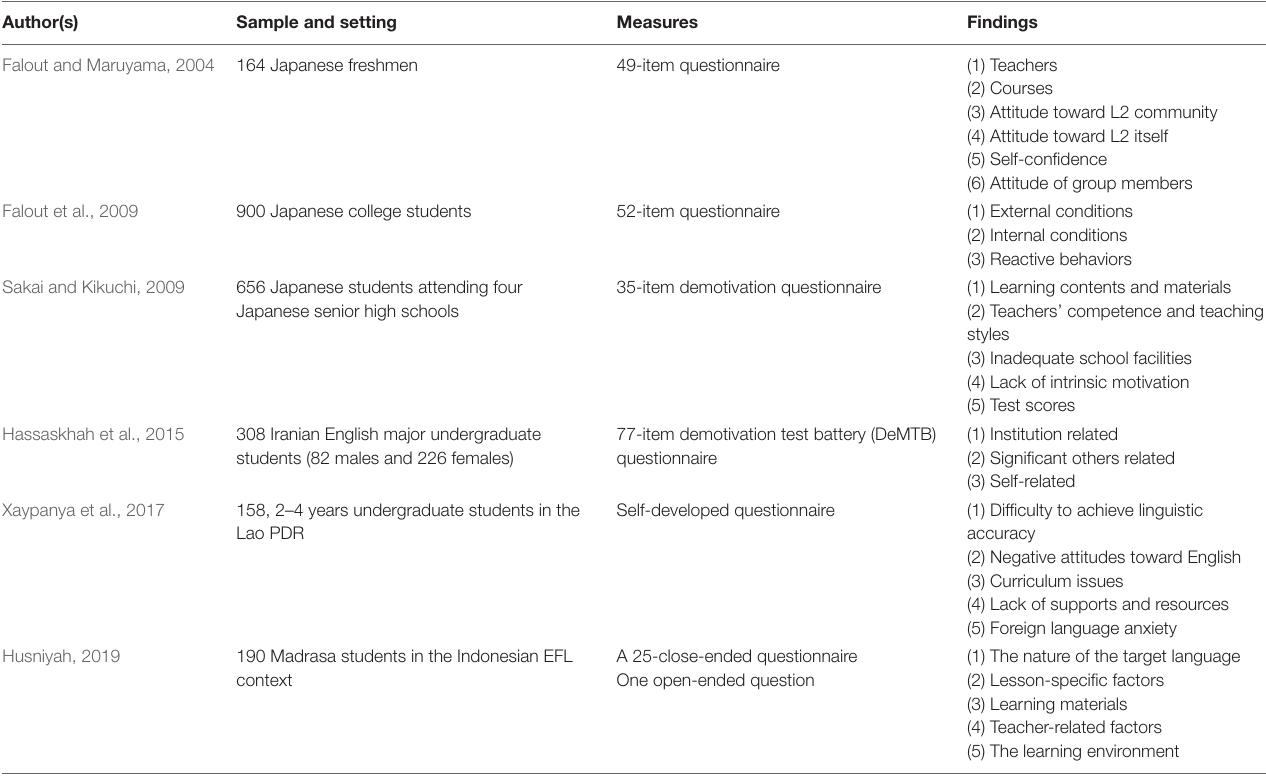
TABLE 1 | Details of some articles exploring second language (L2) learning